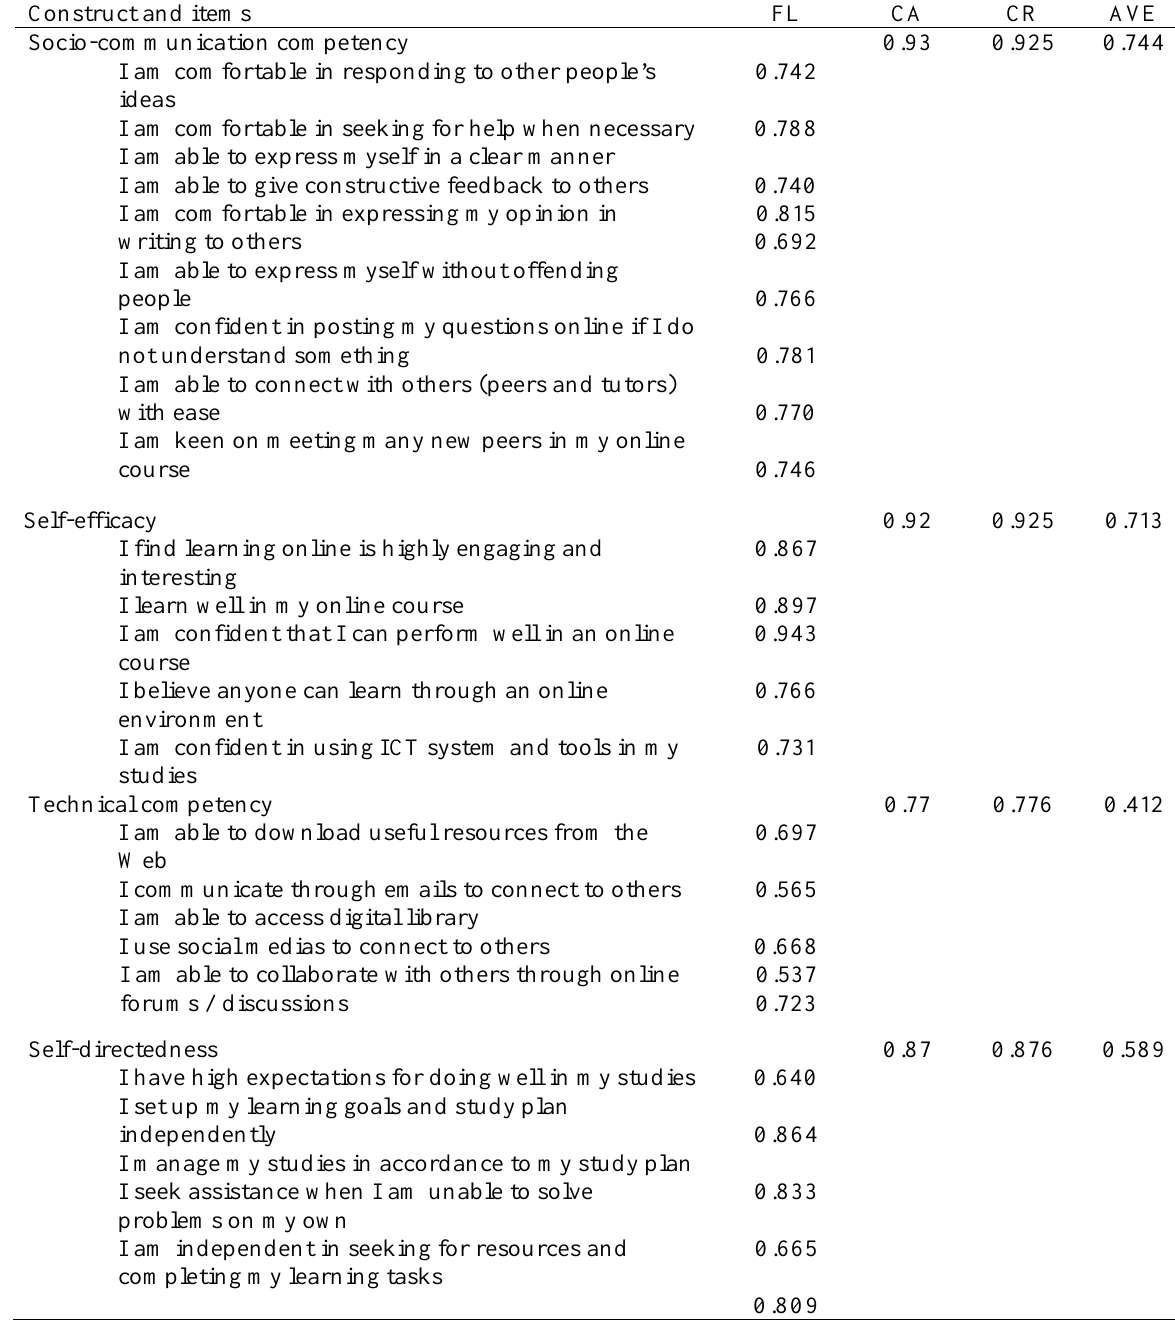
Table 8 Factor Loading, Cronbach’s Alpha, Composite Reliability, and Average Variance Extracted Construct and items FL CA CR